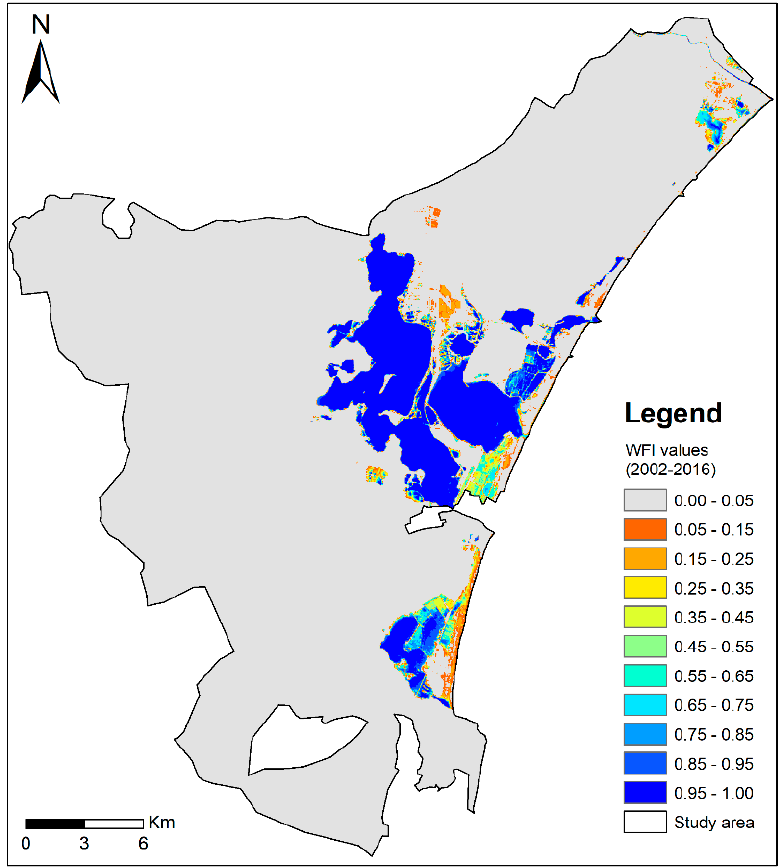
Figure 6. Map of surface water frequencies covering the study area for the entire time series 2002–2016.